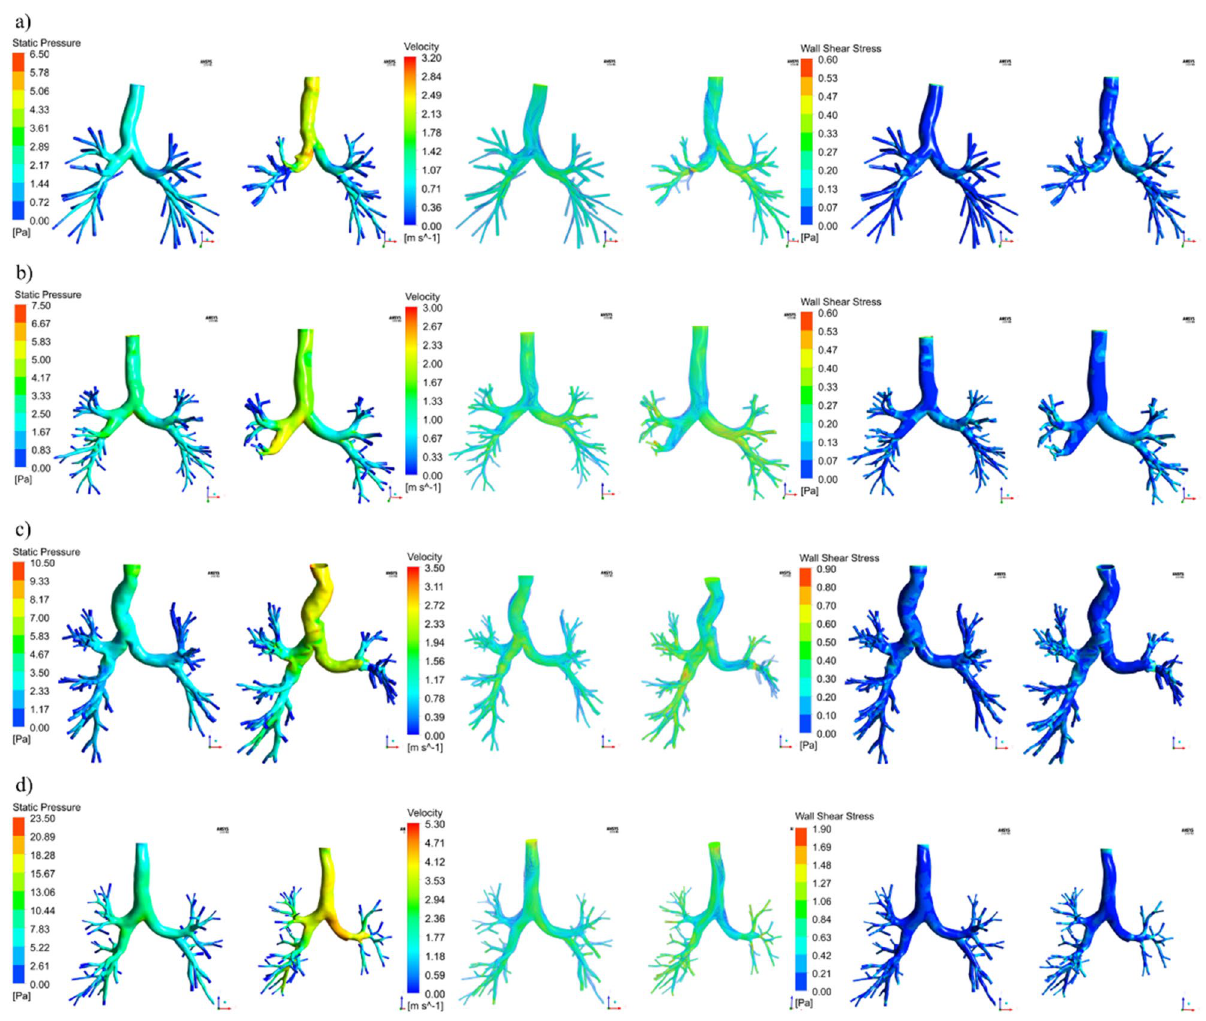
Figure 2. Contours of wall pressure (left), velocity streamlines (middle), contours of wall shear stress (right) on the global models for four representative subjects. ( a ) subject 2, right upper pulmonary lobectomy; ( b ) subject 6, right lower pulmonary lobectomy; ( c ) subject 9, left upper pulmonary lobectomy; ( d ) subject 12, left lower pulmonary lobectomy (Fluent v16, CFD-Post v16-Ansys, www. ansys.